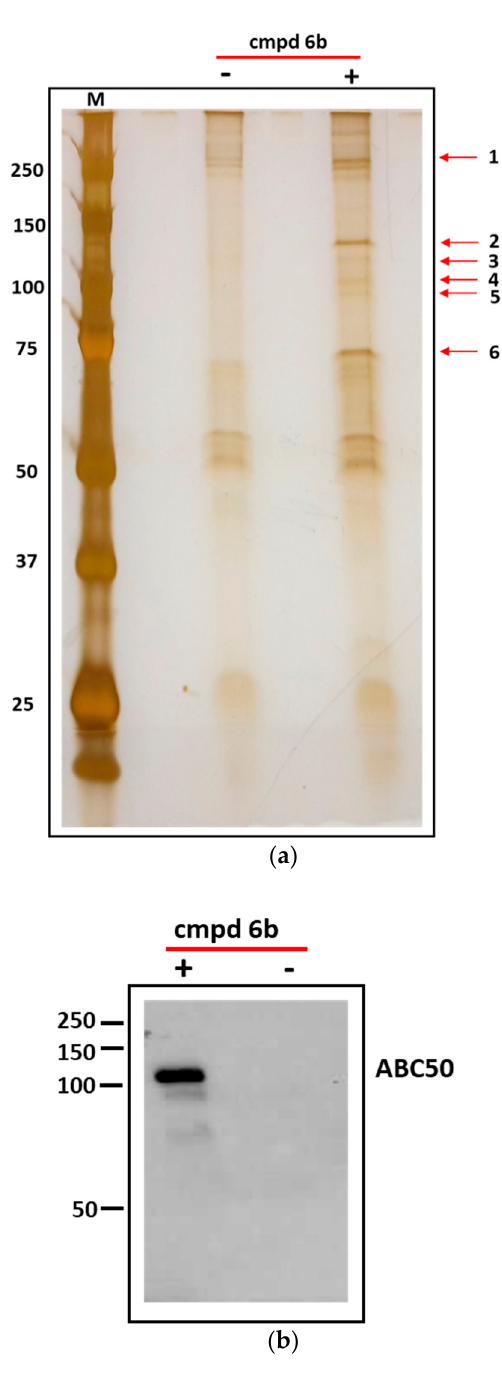
Figure 5. ( a ) SDS-PAGE of the streptavidin-agarose pull down samples obtained from lysates of K562 alone or incubated with 6b . The gel was silver stained. M—protein marker lane in kDa. Numbers on the right correspond to band number entries in Table 3 (below). ( b ) Western blot identification of ABC50 in a material pulled-down from lysates of K562 cells. Mouse monoclonal anti ABC50 antibodies were used. Pull-down was performed in the presence (+) or in the absence ( − ) of compound 6b . Table 3. Identification of cellular proteins pulled-down with 6b .